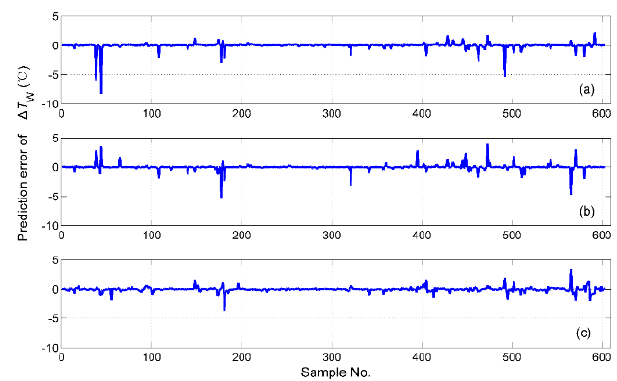
Figure 21. The prediction errors of ∆𝑇 𝑊 for different fusion schemes, namely: ( a ) feature level data fusion; ( b ) decision level data fusion; ( c ) hybrid multi-sensor data fusion.